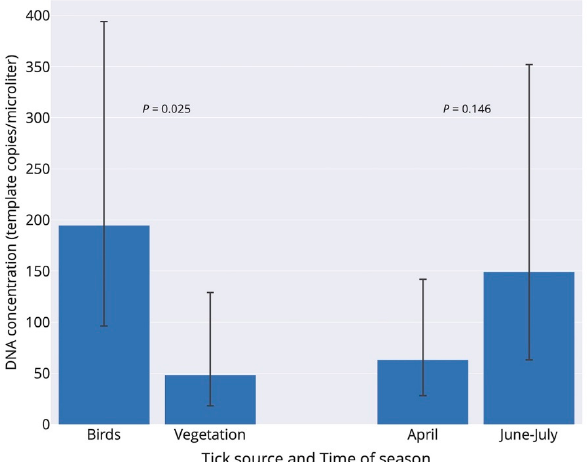
Figure 2. Infection intensity of Borrelia garinii in Ixodes ricinus ticks with respect to tick source (two bars in left) and time of season (two bars in right) in Slovakia. Infection intensities (number of copies / µ L) refer to back-transformed estimates from the negative-binomial generalized linear model. Birds ( n = 21 ticks) and vegetation ( n = 11 ticks) denote bird-feeding and questing ticks, respectively. Bird-feedin ticks comprised 5 larvae and 16 nymphs, whereas questing ticks comprised 10 nymphs and 1 adult. The data for June and July were pooled. Errors are 95% confidence